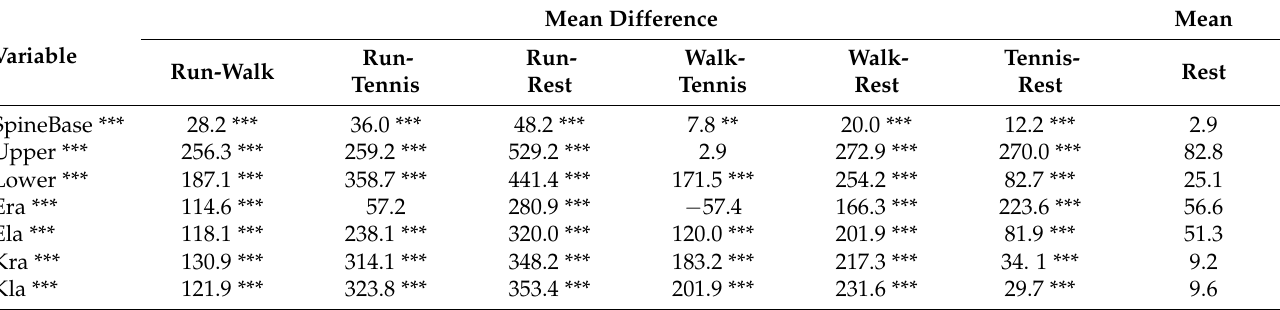
Table 5. Multiple comparison of effects of exercise types on Kinect data.